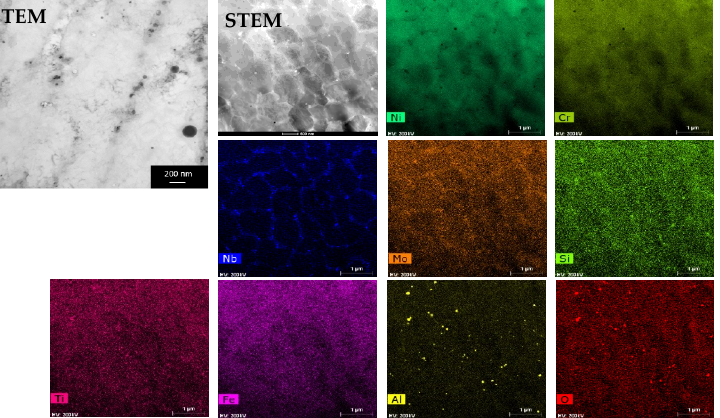
Figure 4. TEM, STEM-HAADF, and EDS spectral images showing maps of constituent chemical elements in the L-PBF Inconel 625 stress-relieve annealed at a temperature of 980 °C for 1 h.